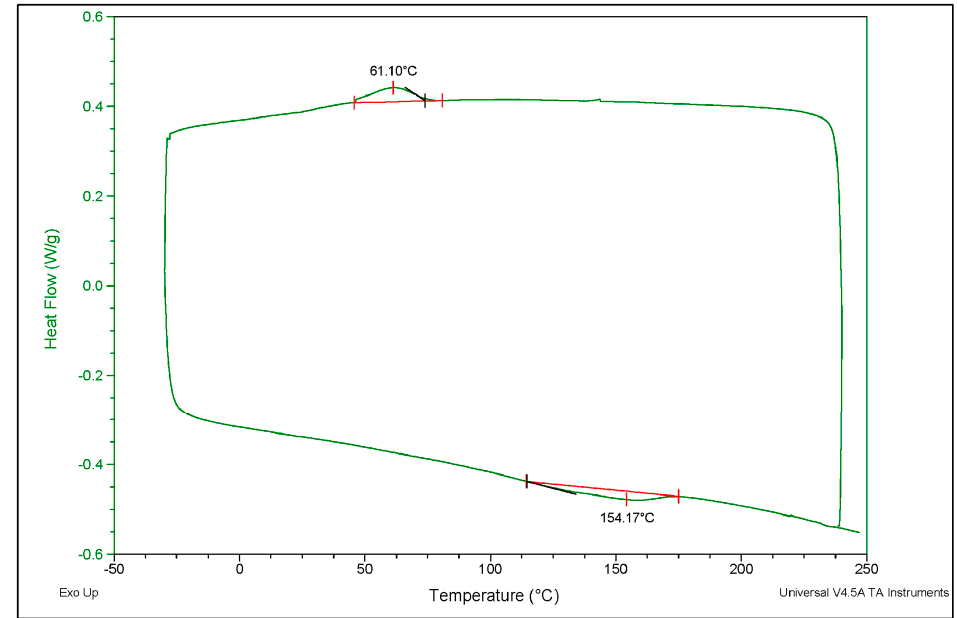
Figure A1. Exemplary di ff erential scanning calorimetry (DSC)-curve of the first cooling and second heating run of the virgin (R0) material under 10 K / min temperature ramp. The corresponding crystallization and melting peaks are